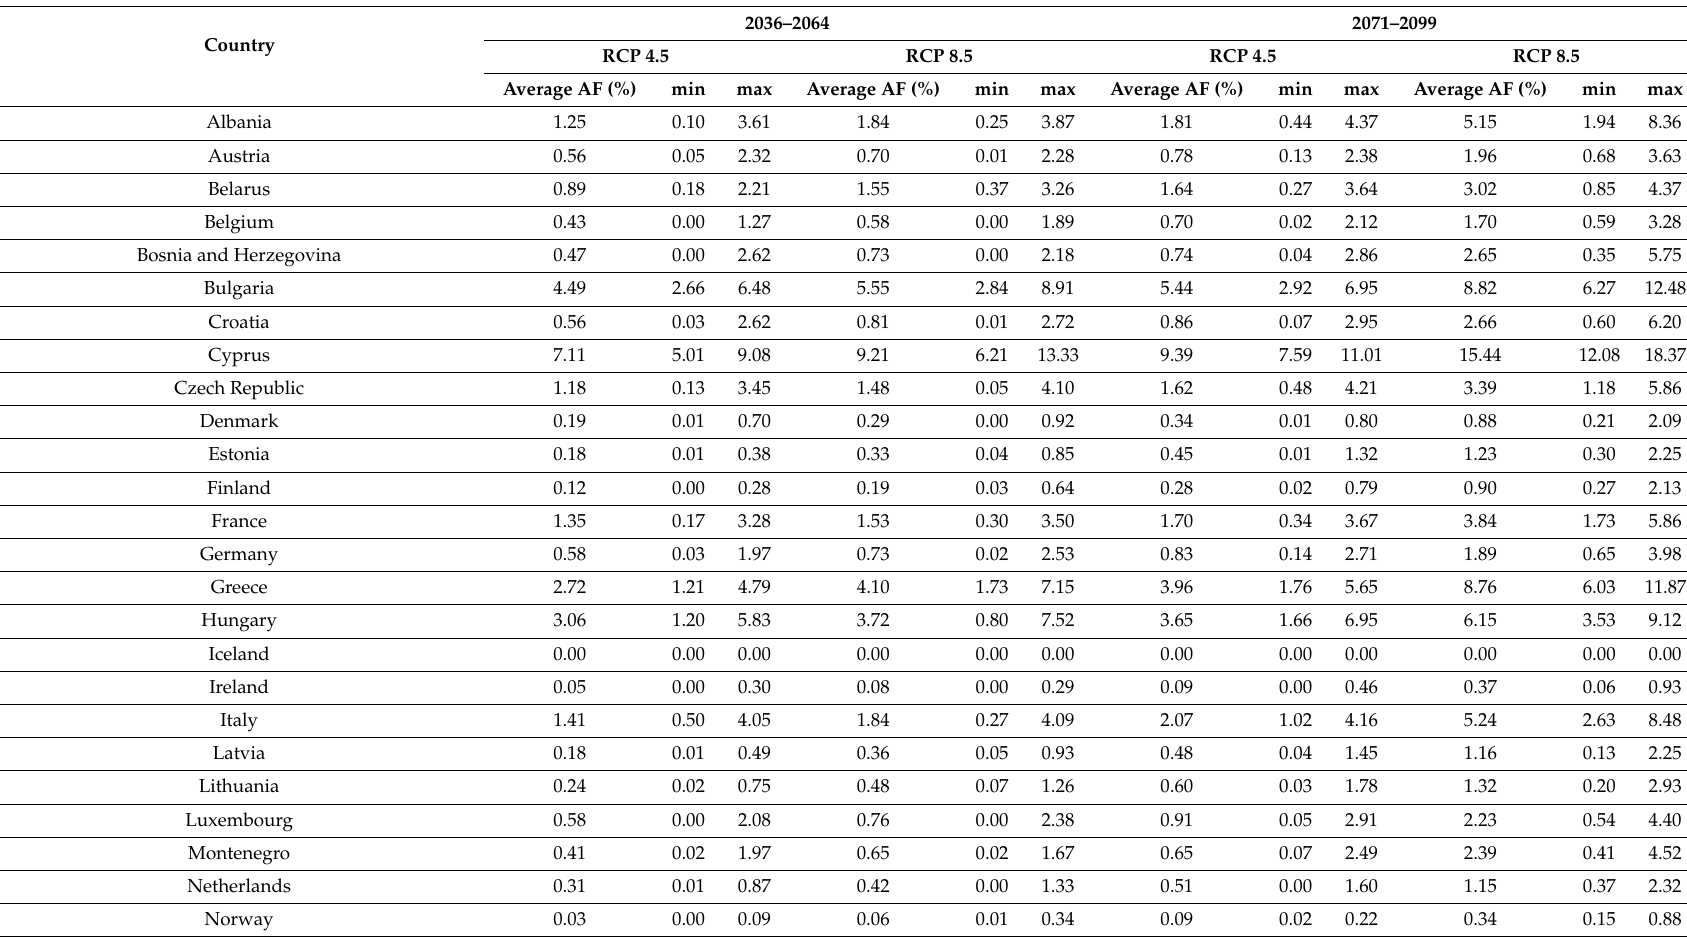
Table A3. Average, maximum and minimum attributable fractions evaluated over the future time slices 2036–2064 and 2071–2099 under the RCP 4.5 and RCP 8.5 scenarios.